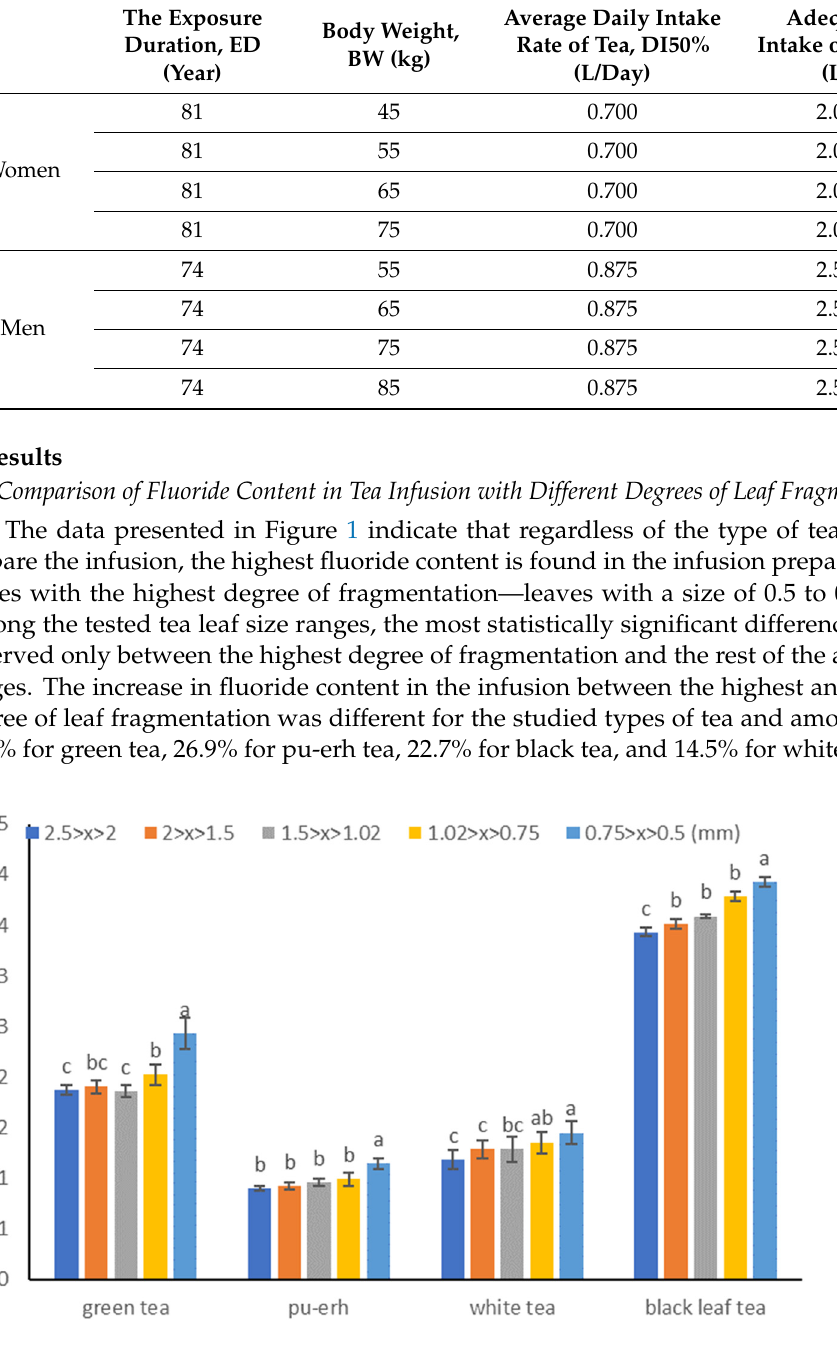
Figure 1. Mean and SD fluoride concentration (mg/L) in the tea infusions for different degrees of leaf fragmentation. Different letters (a, b, c, etc.) show a significant difference with p < 0.05. The differences relate to each type of tea separately.